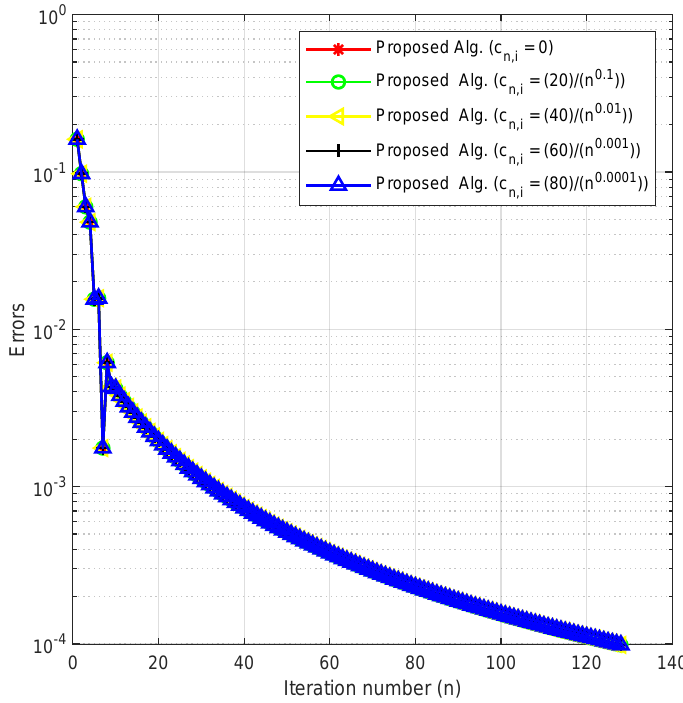
Figure 8. Experiment 3: Case